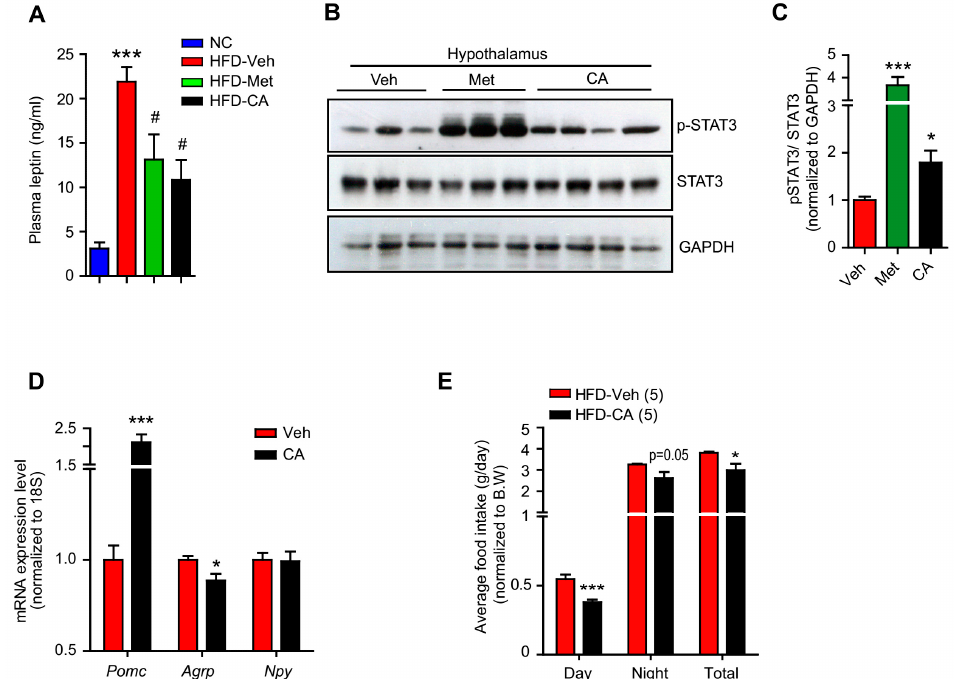
Figure 3. CA treatment enhanced hypothalamic leptin sensitivity. ( A ) Plasma leptin levels of normal chow (NC)-fed mice and high-fat diet (HFD)-fed mice treated with vehicle (veh), CA, and metformin (met). *** p < 0.001 compared to NC, # p < 0.05 compared to HFD-Veh. Immunoblots ( B ) and graph ( C ) showing effects of vehicle, CA, and metformin treatments on STAT3 downstream signaling in the hypothalamus samples. * p < 0.05, *** p < 0.001 compared to Veh. ( D ) Transcriptional expression of Pomc , Agrp, and Npy in the hypothalamic N1 cells under vehicle and CA treatments. ( E ) Daily food intake of HFD-fed mice treated with vehicle and CA (averaged from 3 days). The results are expressed as mean ± SEM. One-way ANOVA with Tukey’s post-hoc tests for comparison of multiple groups or Student’s t-test. * p < 0.05, *** p < 0.001.